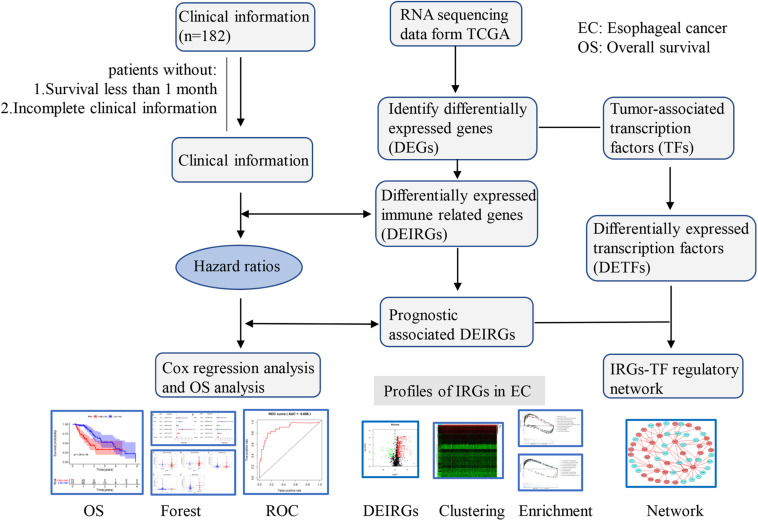
Flowchart of the study. RNA-Seq data and corresponding clinical information of EC cohort were downloaded from the TCGA data portal. After excluding patients with incomplete clinical data and duplications, the complete data was used for subsequent analysis.